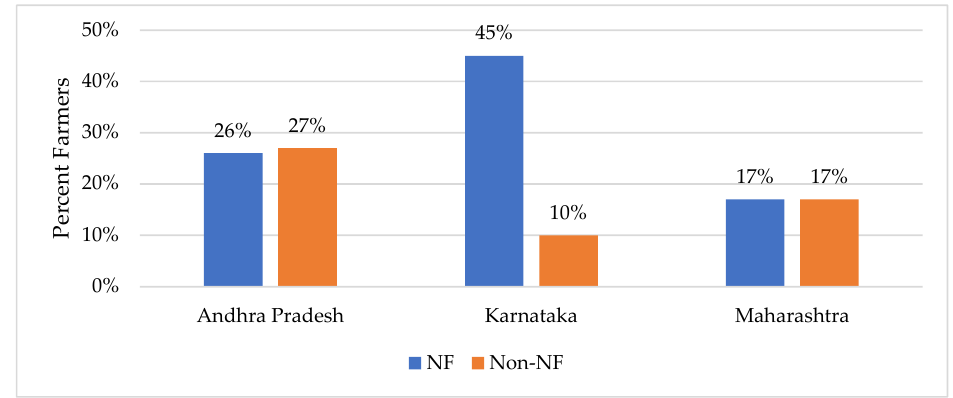
Figure 3. Percentage of sample farmers following mixed cropping or intercropping in natural farm- ing.